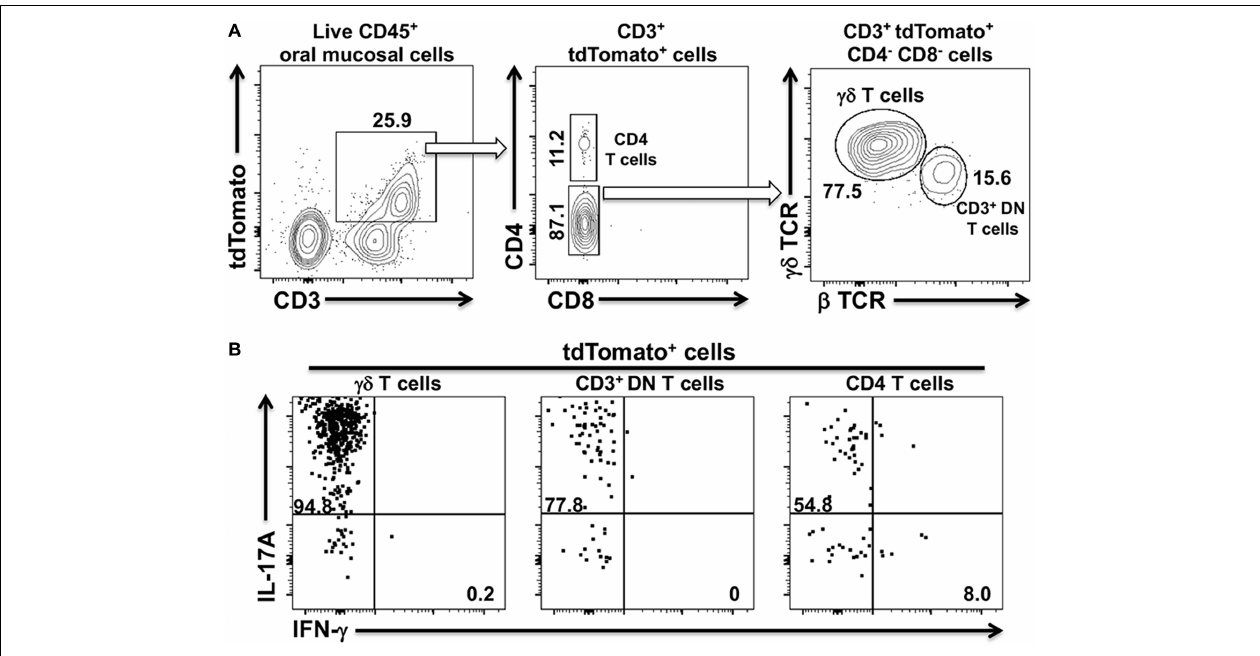
FIGURE 3 | tdTomato expression in three distinct CD3 + T cells populations within the oral mucosa of IL-17A cre fate-tracking mice. Oral mucosa was harvested from IL-17A cre fate-tracking mice and single cell suspensions prepared from the tissue for subsequent analysis by flow cytometry. Single cell suspensions were stained with vitality dye Zombie Aqua followed by a panel of anti-mouse mAbs to identify immune cell subsets expressing tdTomato. Cells were counted by flow cytometry and analyzed by FlowJo software. (A) Representative flow cytometry plots showing gating strategy to identify three tdTomato + cell populations. Numbers indicate the% of cells within a particular gate. Live CD4 + T cells were identified as Zombie Aqua lo , CD45 + , CD3 + , CD4 + , CD8 α − , NK1.1 − ; live γδ T cells as Zombie Aqua lo , CD45 + , CD3 + , γδ TCR + , β TCR − , CD4 − , CD8 α − , NK1.1 − ; live CD3 + DN T cells as Zombie Aqua lo , CD45 + , CD3 + , β TCR + , γδ TCR − , CD4 − , CD8 α − , NK1.1 − . (B) Representative flow cytometry plots showing expression of IL-17A and IFN- γ in the three CD3 + tdTomato + cell populations. Single cell suspensions obtained from oral mucosa were cultured and stimulated with PMA/ionomycin in the presence of brefeldin A. Cells were surface stained with anti-mouse mAbs as in (A) and then intracellularly with anti-mouse IL-17A and IFN- γ